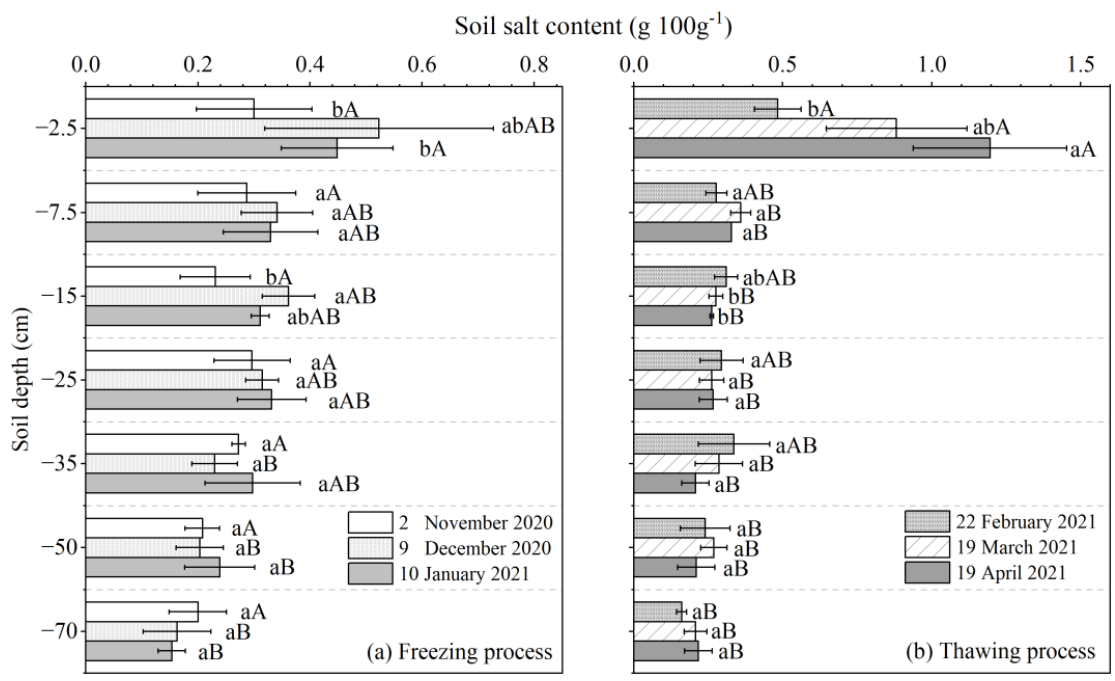
Figure 4. Changes in soil salt content (SSC) during the freeze–thaw process. Note: Different lowercase letters indicate significant differences between different times ( p < 0.05). Different capital letters indicate significant differences between different soil layer ( p < 0.05). The horizontal line represents the S.D. of the average.